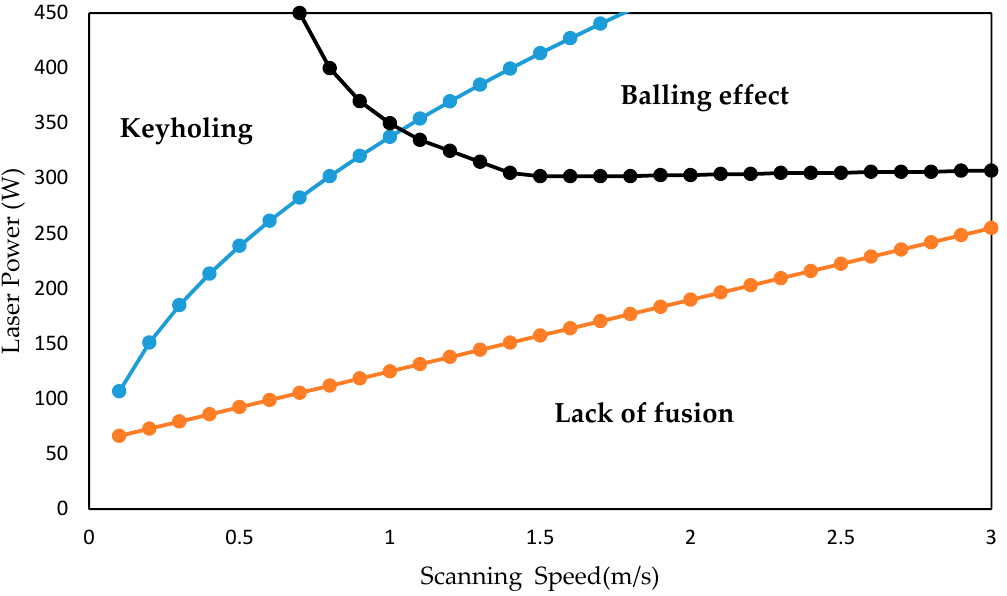
Figure 8. The e ff ect of laser power and scanning speed on defects of In718 by